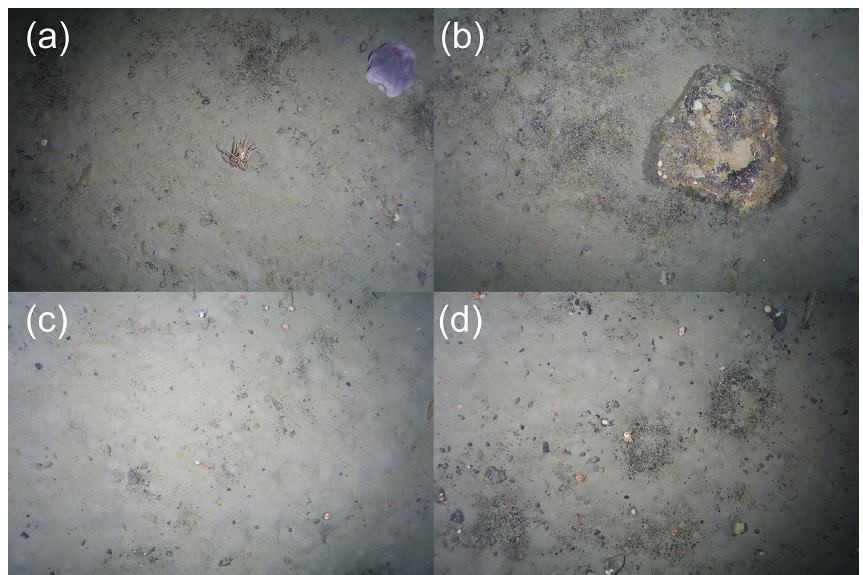
Figure 8. Typical seafloor images collected from each of the OFOBS surveys made of the central Filchner Trough seafloor dur- ing RV Polarstern cruise 124. All images were taken at Station PS124_72-08. (a) SW_RELEASER_2021_03_02 at 00_48_38 IMG_0091.JPG, (b) SW_RELEASER_2021_03_02 at 01_08_57 IMG_0159.JPG, (c) TIMER_2021_03_02 at 03_44_06 IMG_0650.JPG, (d) SW_RELEASER_2021_03_02 at 04_08_38 IMG_0726-IMG. The three red points within each image represent the sizing lasers (50cm spacing). All images are presented here and in the dataset with no manipulation or colour